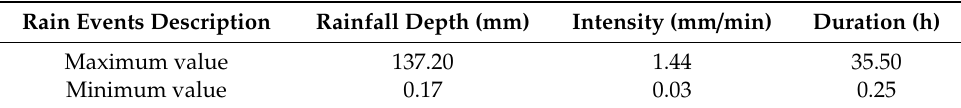
Table 2. Extreme rain events description.